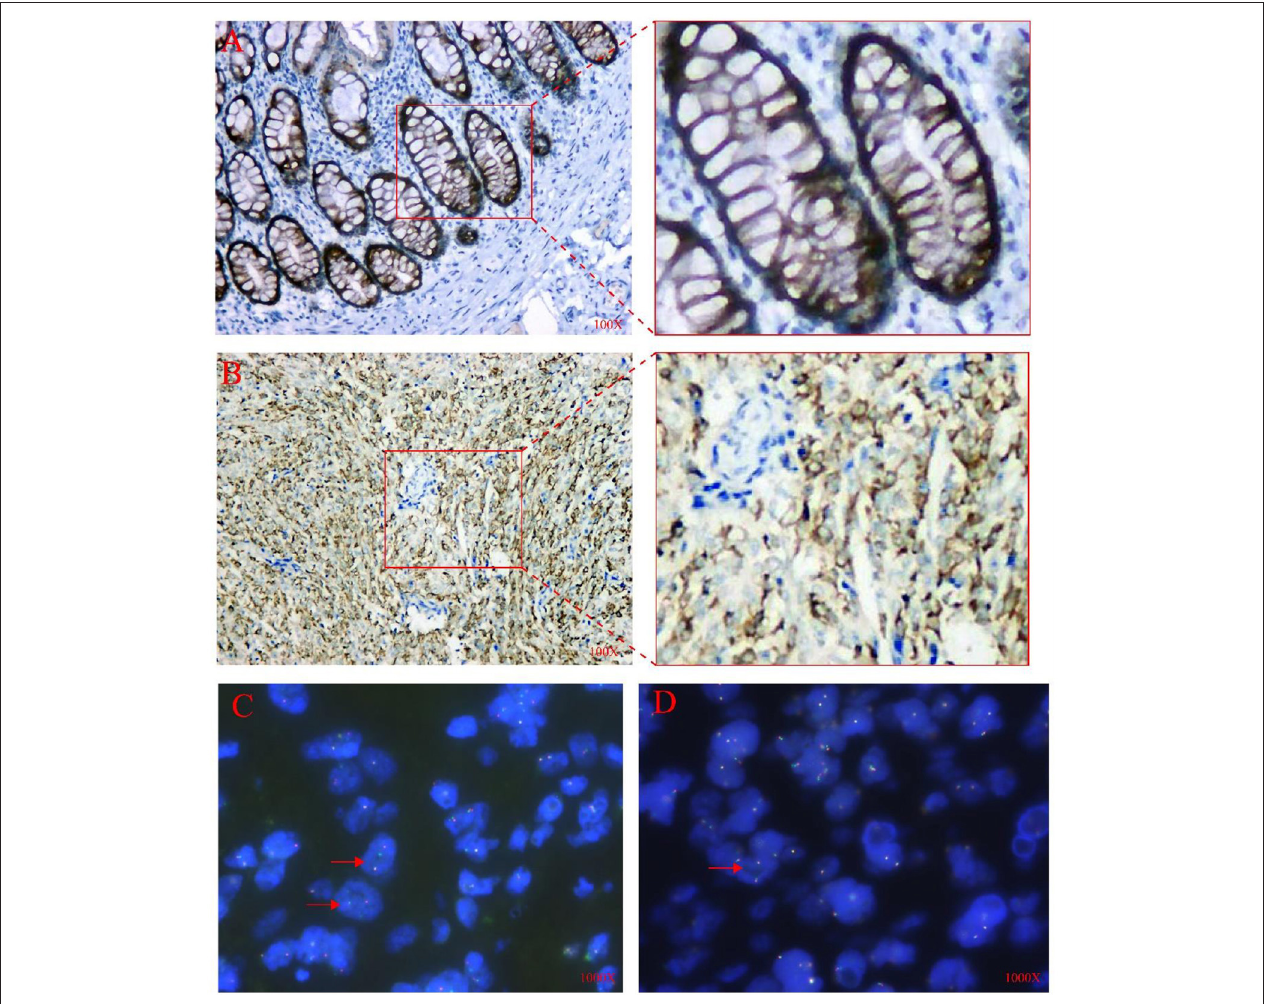
FIGURE 4 | IHC and FISH analysis results. (A) Positive control for MUC4 showing normal (colon glands), 100X. (B) The tumor cells were diffusely positive for MUC4 in the cytoplasm,100X. (C) FISH analysis using the EWSR1 dual-color break-apart probe showed one red/green fused signal and one or two red split signals per nucleus in several tumor cells (shown by arrows),1000X. (D) FISH analysis using FUS dual-color break-apart probe revealed more than two red/green fused signals per nucleus in most tumor cells (shown by arrow), 1000X.